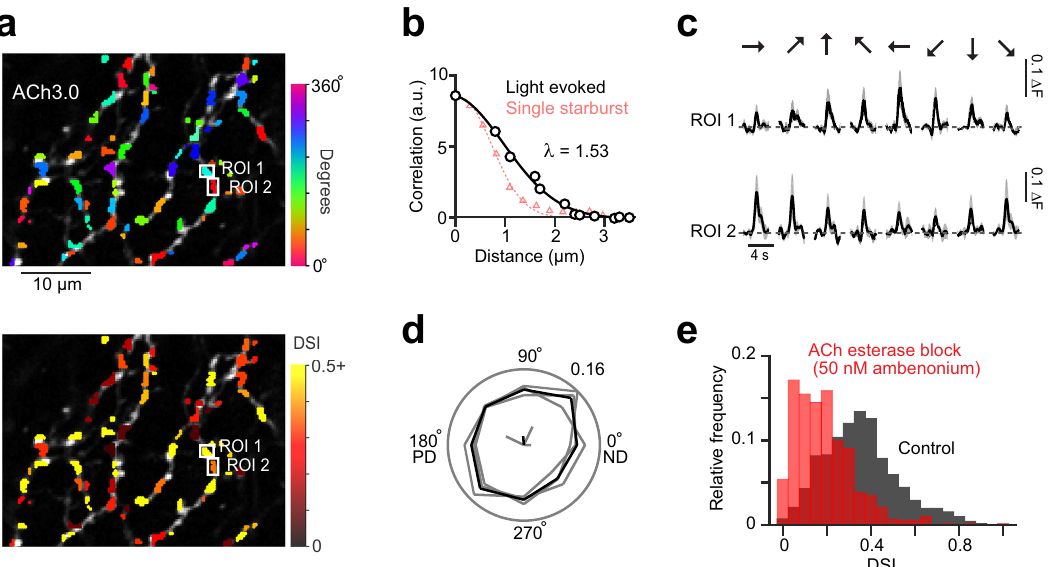
Fig. 7 ACh signals in DSGCs are locally, but not globally, tuned for direction. a Two photon image of DSGC dendrites selectively labeled with ACh3.0, using the Oxtr-T2A-Cre mouse line (see Supplementary Fig. 7 for a more detailed characterization of this new mouse line). The colors indicate the preferred direction for each site (top), and its tuning strength (bottom), quanti fi ed from the responses to spots of light moving in 8 directions (See methods). Tuning strength was quanti fi ed from the direction selectivity index (DSI; See Eq. 4), where 0 indicates non-tuned, and 1 indicates responses only in the preferred direction. In total, 10 such fi eld of views were imaged from 3 DSGCs. b Noise correlations (trial-to-trial fl uctuations around the mean ACh3.0 signal) plotted over distance ( λ , space constant; black). The spatial decay of ACh signals associated with single starburst stimulation measured in Fig. 6d is shown for comparison (red) (a.u., auxiliary units). c Example ACh Δ F signals evoked by spots moving in 8 different directions, measured in the two ROIs shown in a . Data represented as mean (black) ± SEM (gray) from 4 trials. d Relative frequency histogram of the preferred directions of all the ROIs in polar form ( p = 0.81, n = 723 ROIS, 3 DSGCs; Hodges-Ajne non-parametric test for angular uniformity of the data) indicates a random distribution of angles with respect to the DSGCs preferred and null directions (PD and ND, respectively). e Relative frequency histogram of the DSIs of all the ROIs in control, and in the presence of an ACh esterase blocker (50 nM ambenonium). Source data are provided as a Source Data fi le for Fig. 7b, d,